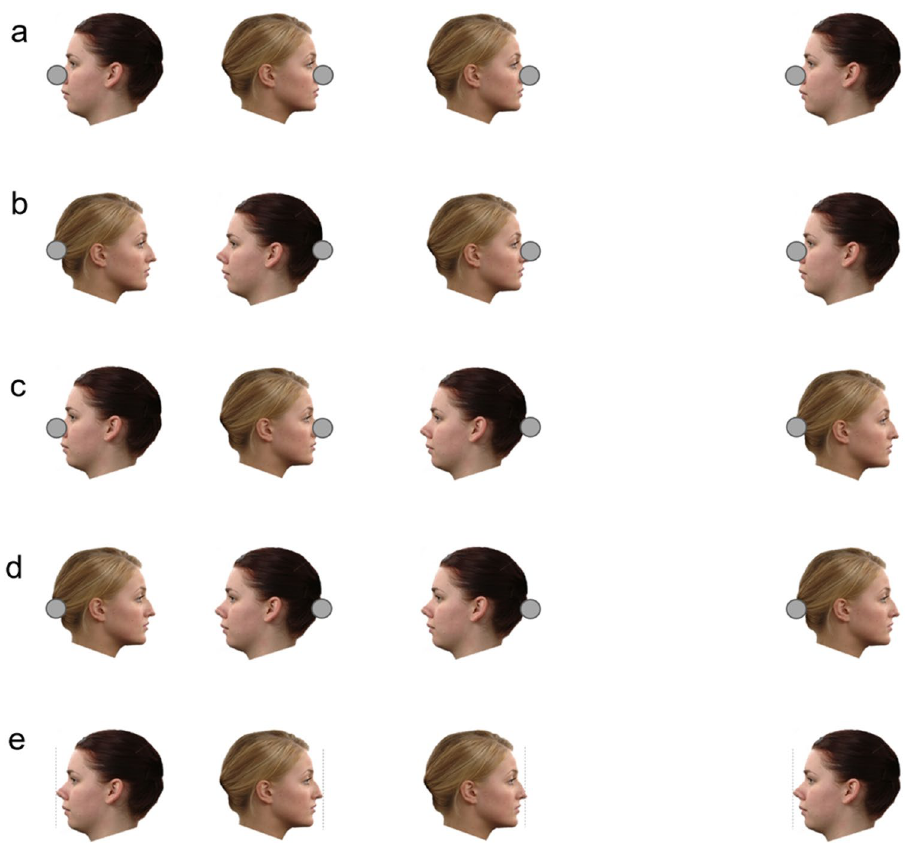
Figure 3. The Müller-Lyer illusion induced by faces. (a–d) Faces produce the illusion irrespective of their arrangement. In each case, the target circles are the same distance apart in the left and right arrangements, but they appear closer together in the arrangements on the left. (e) The effect manifests strongly in the absence of the target circles. The tips of the noses are equidistant in both arrangements, but appear closer in the back-to- back arrangement. Face images were taken from the Radboud Faces Database 37